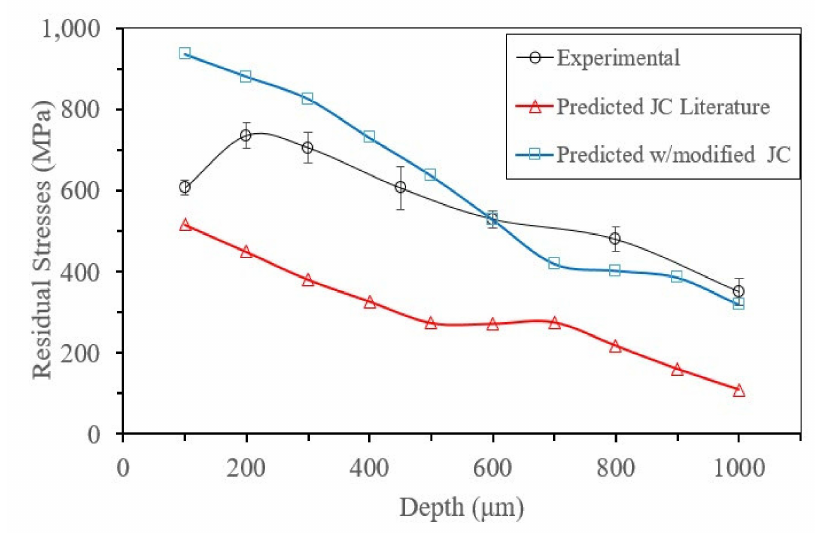
Figure 43. In-depth RS prediction at 220 W, 650 mm/s, and 0.12 mm.